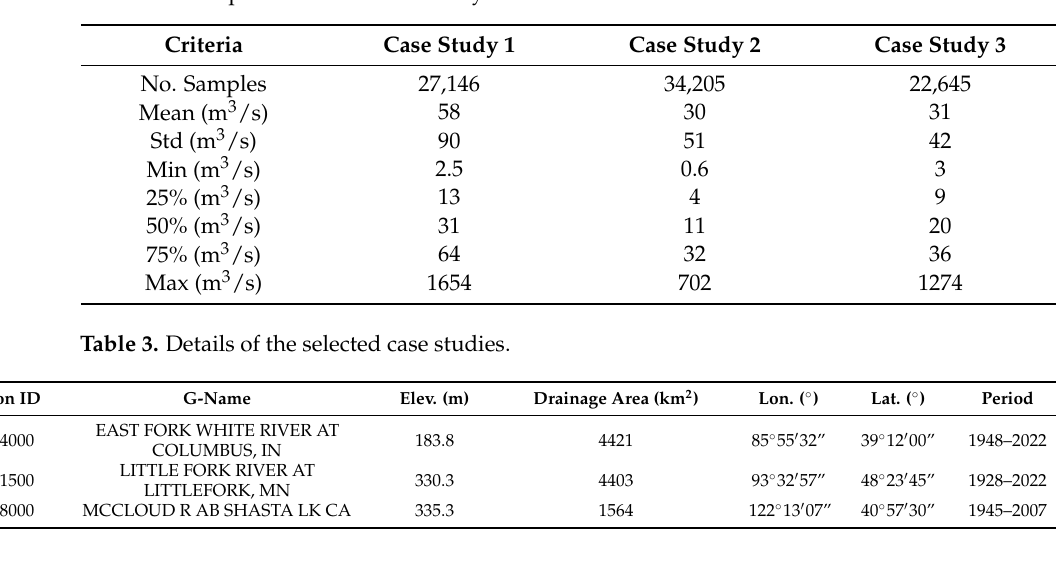
Table 2. Descriptive information of daily historical streamflow data for three case studies.